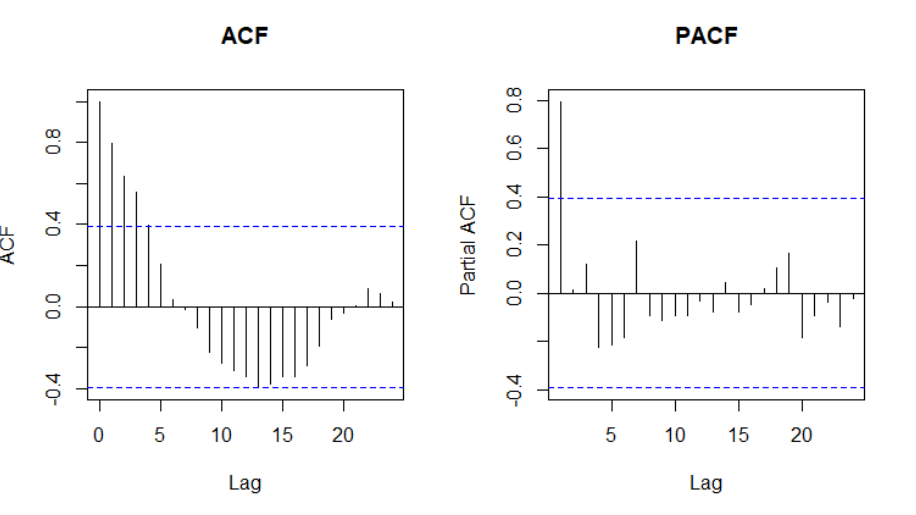
Figure 3. ACF and PACF for the EBITDA index.